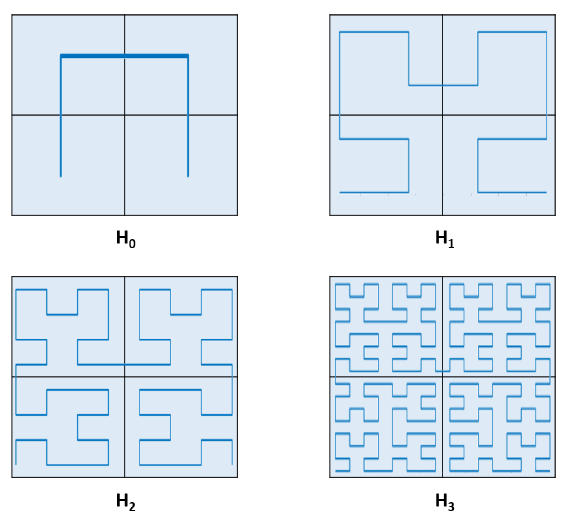
Figure 5. The first four stages of the construction of a Hilbert fractal, axiom = D (see Section 5.3) employed by David Hilbert in